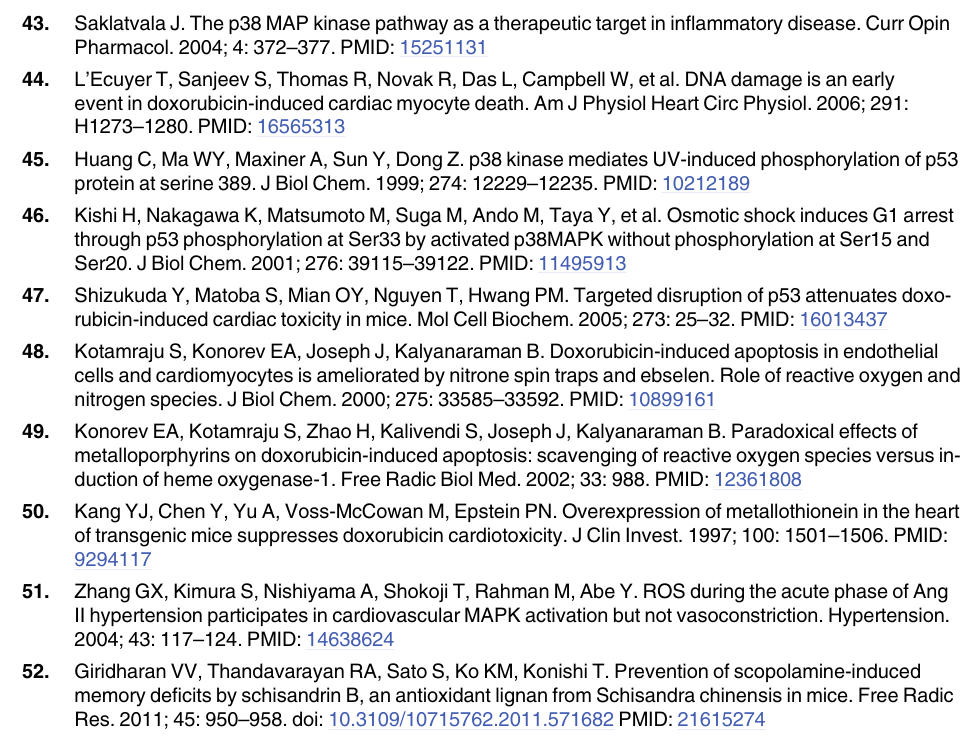
PLOS ONE | DOI:10.1371/journal.pone.0119214 March 5,